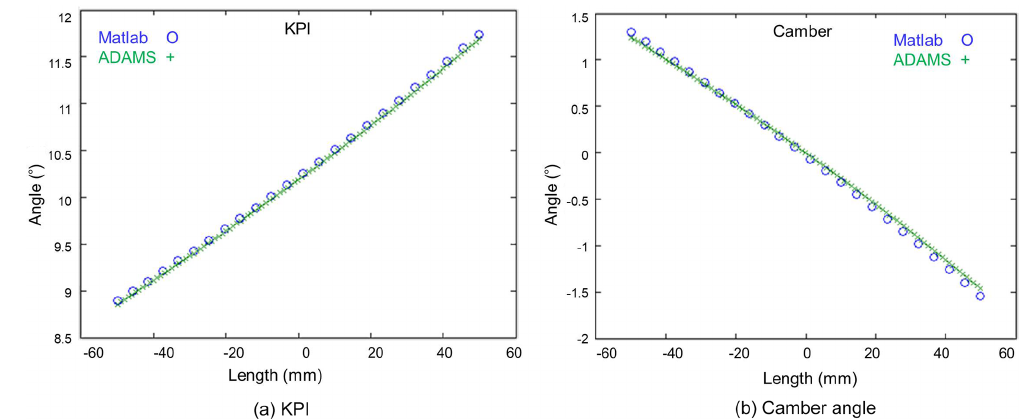
Figure 8. Comparison of simulation and mathematical results with tire displacement.